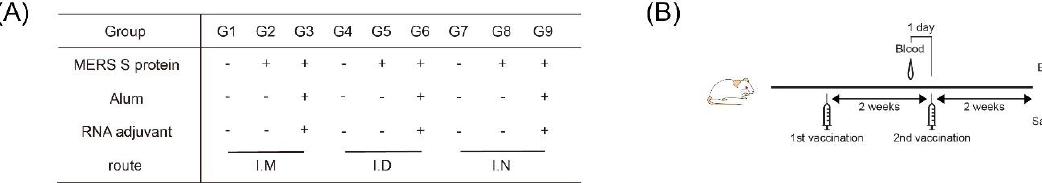
Figure 1. Group design and immunization schedule for Middle East respiratory syndrome (MERS) spike (S) protein. BALB/c mice were intramuscularly (I.M.), intradermally (I.D.), and intranasally (I.N.) immunized, at two-week intervals, with two doses of MERS S soluble protein vaccine with/without RNA adjuvant or alum. ( A ) Overall study design. ( B ) Schedule for mice vaccination.